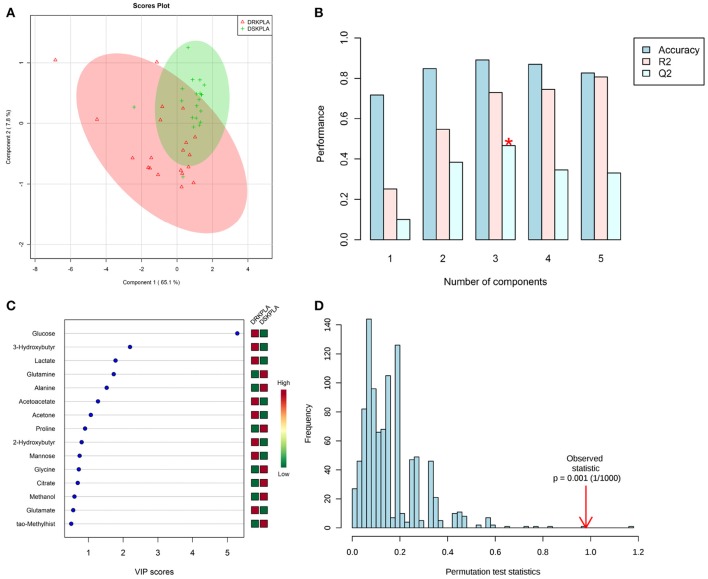
PLS-DA analyses of the DRKPLAs and the DSKPLAs serum samples. (A) Two-dimensional PLS-DA score plot. (B) PLS-DA classification using different numbers of components. The red asterisk indicates the best classifier. The inset table summarizes the Q2, R2 and accuracy of the best model. (C) Important features identified by the VIP scores. The variable importance in projection score is a weighted sum of squares of the PLS-DA loadings that accounts for the amount of explained Y-variation in each dimension. (D) Permutation test statistics for 1,000 permutations with the observed statistic at p < 0.01.